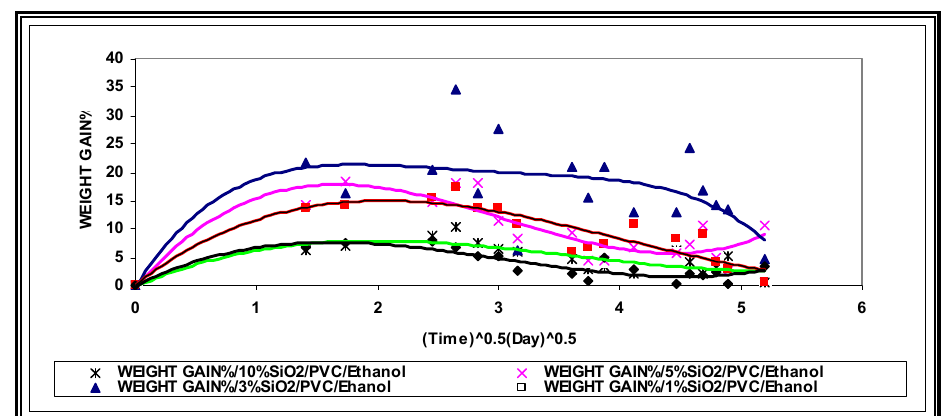
Fig. 8: Weight gain (%) of PVC & SiO